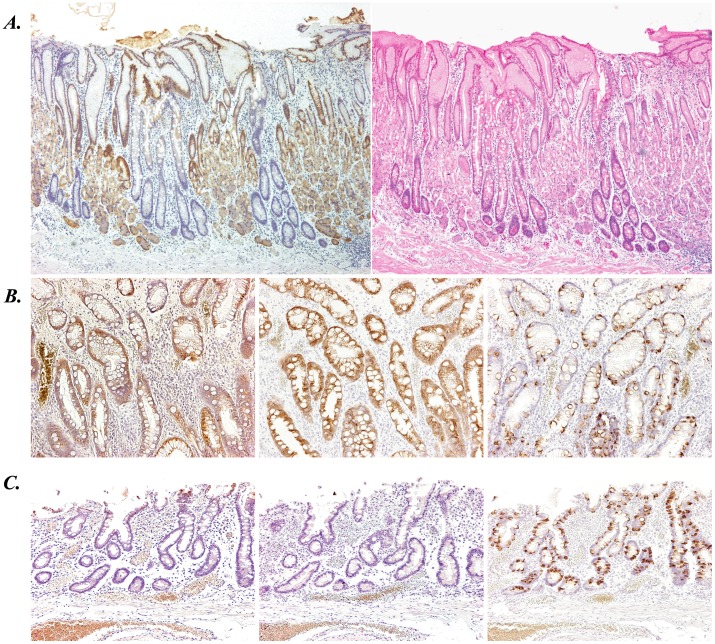
Expression of CTSE in non-malignant but precancerous gastric mucosa analyzed with immunohistochemistry.(A) CTSE immunostaining (left panel) and HE staining (right panel) of the stomach showing the mixture of normal fundic glands and intestinal metaplastic glands. (B, C) Immunostaining for CTSE (left), MUC5AC (middle), and MUC2 (right) in gastric intestinal metaplasia. Typical images of intestinal metaplasia with mixed gastric- and intestinal- feature (incomplete type, B) and solely intestinal feature (complete type, C) were shown.